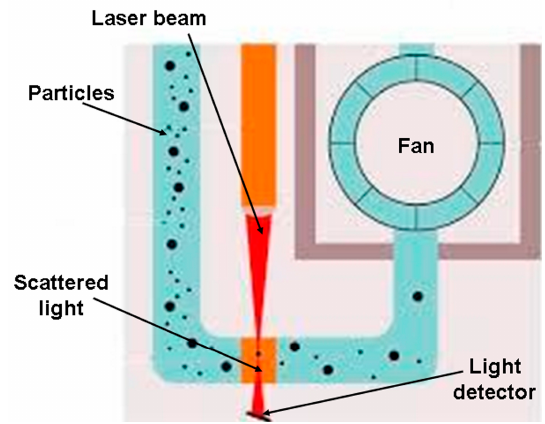
Figure 3. The simplified scheme of an optical counter for PM detection on which the working principle of LCSs used in this research is based.